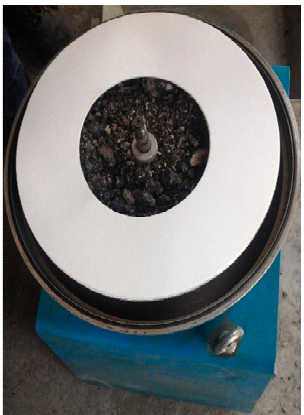
Figure 2. RAP material in Centrifuge Extractor.